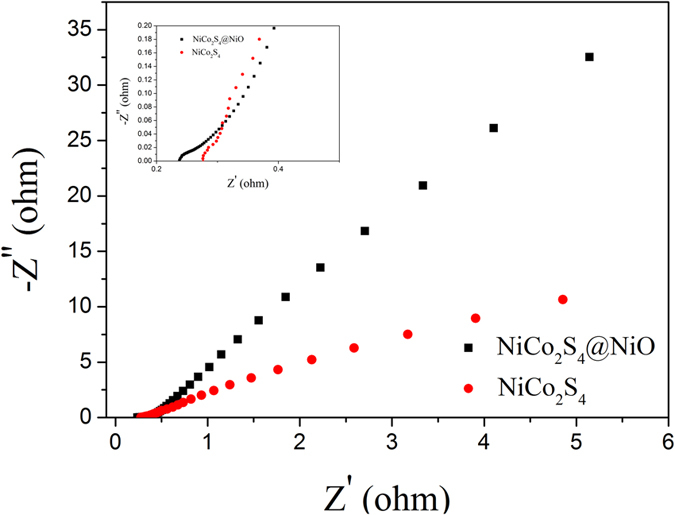
Nyquist plots of NiCo2S4@NiO and NiCo2S4.